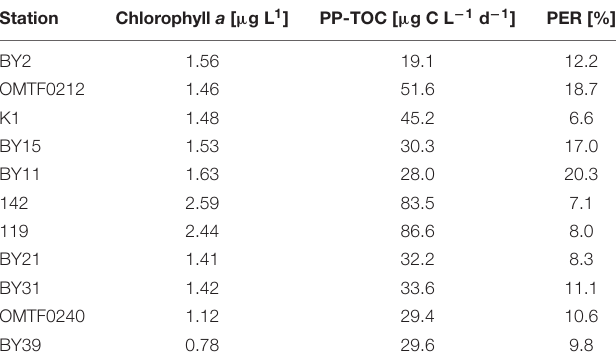
TABLE 1 | Surface chlorophyll a concentration and net primary production.